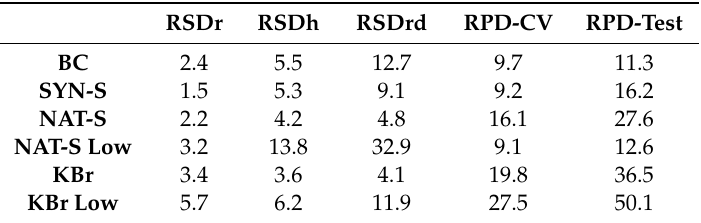
Table 2. Relative standard deviation (RSD) and relative predictive determinant (RPD) values for the models generated. RSDr RSDh RSDrd